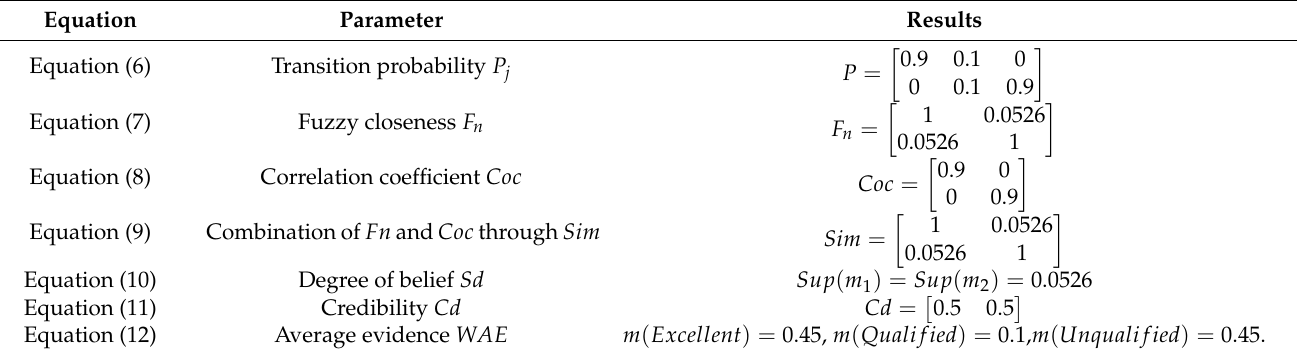
Table 5. The calculation process of the weighted average evidence.